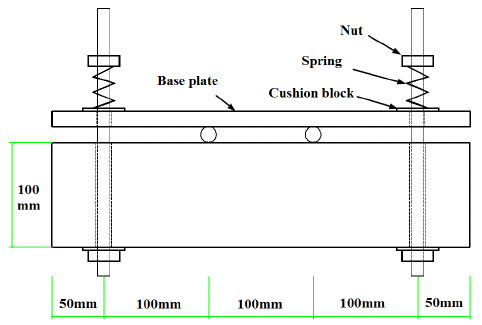
Figure 2. Schematic illustrations of the loading frame.